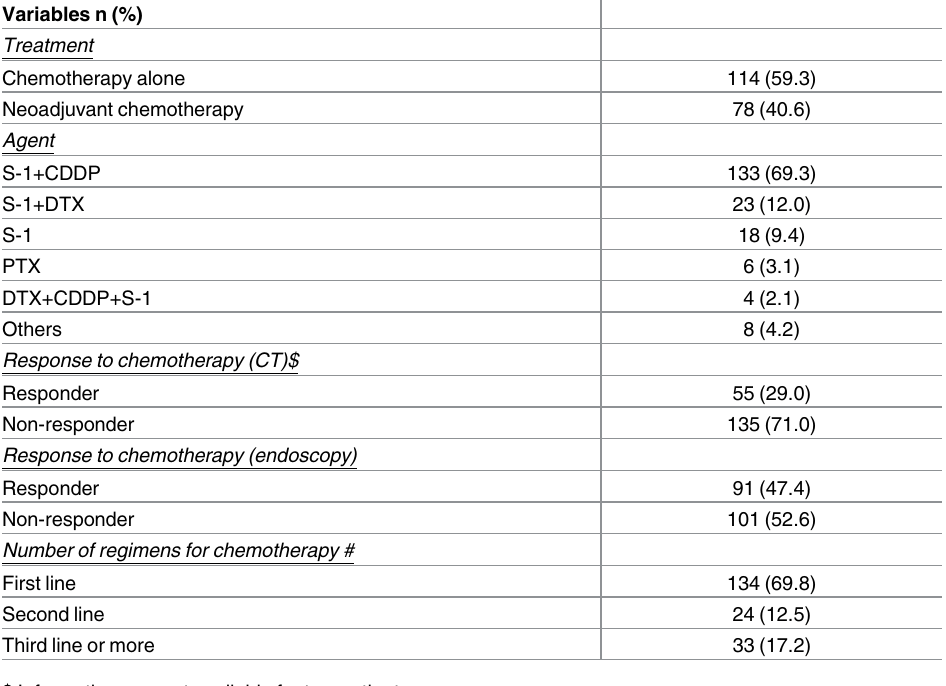
Table 2. Information about treatment of gastric